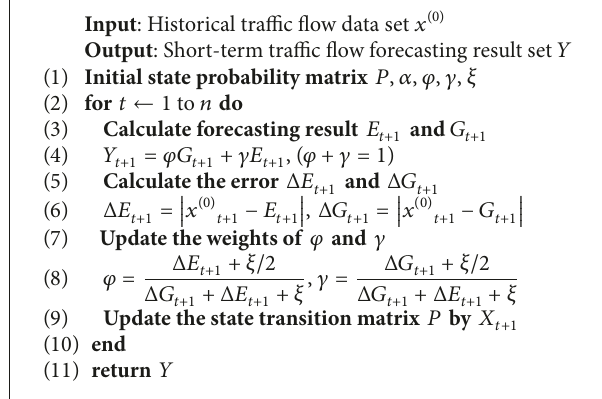
Algorithm 1: Pseudocode of grey differential exponent smoothing.